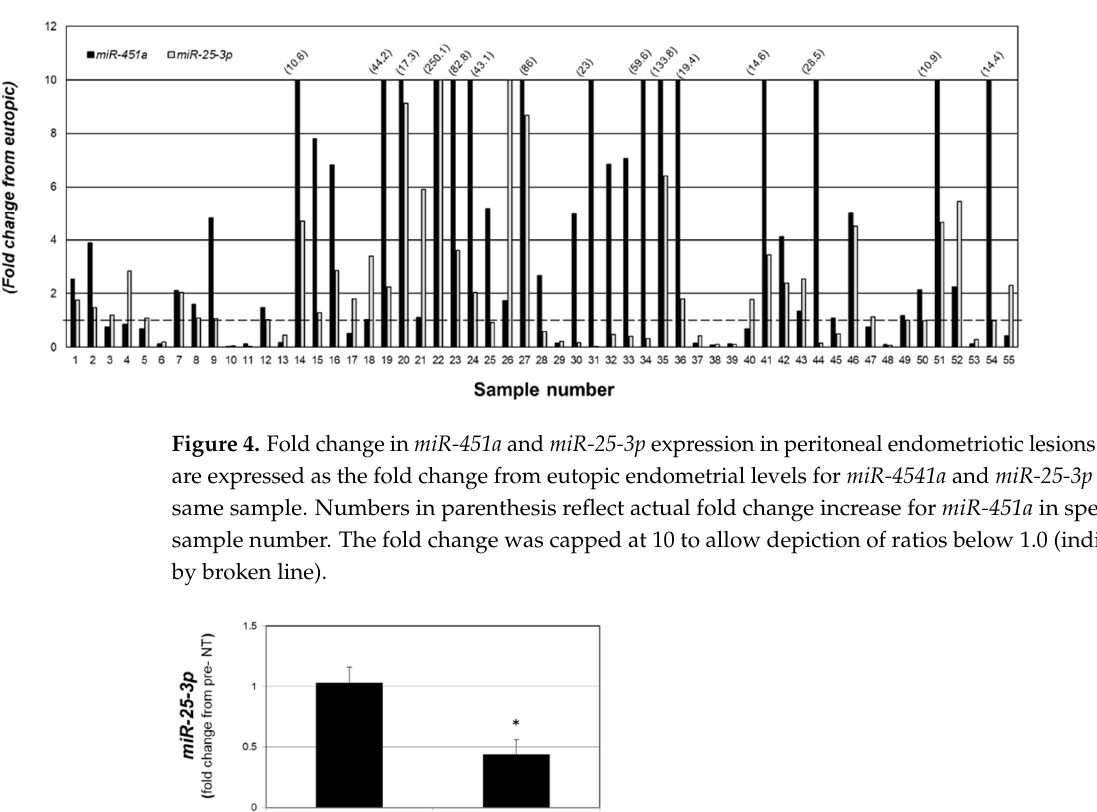
Figure 4. Fold change in miR ‐ 451a and miR ‐ 25 ‐ 3p expression in peritoneal endometriotic lesions. Data are expressed as the fold change from eutopic endometrial levels for miR ‐ 4541a and miR ‐ 25 ‐ 3p in the same sample. Numbers in parenthesis reflect actual fold change increase for miR ‐ 451a in spec ‐ ified sample number. The fold change was capped at 10 to allow depiction of ratios below 1.0 (indi ‐ cated by broken line).